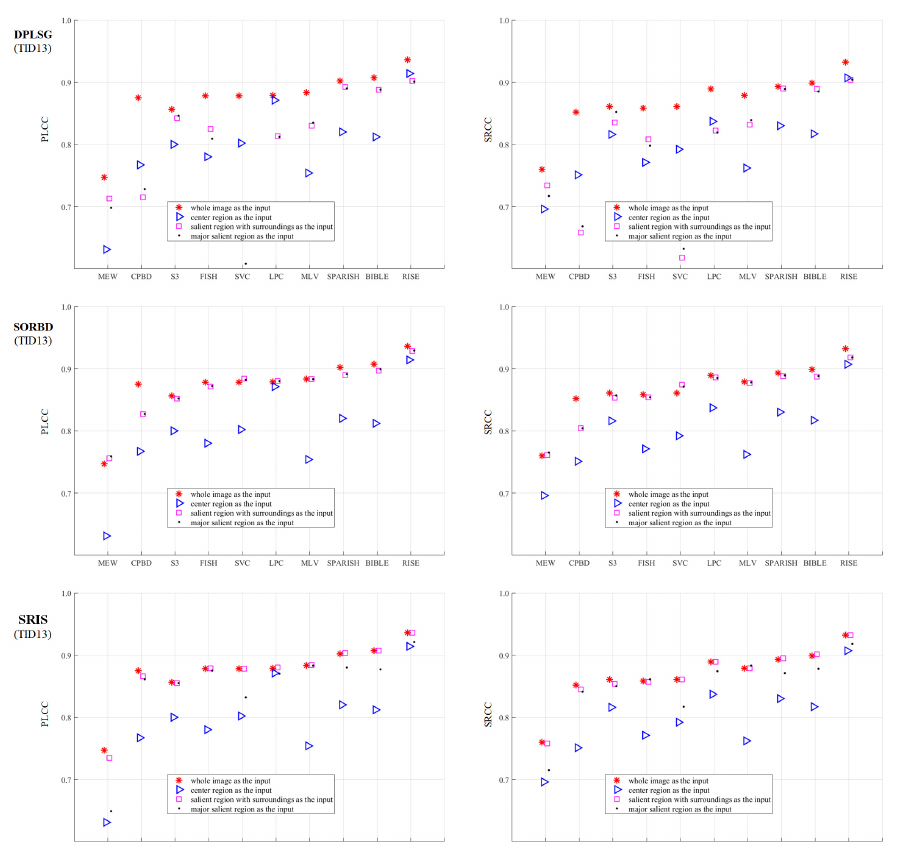
Figure 7. Comparison of BSIA performance on the TID13 Gaussian blurring images. The metric values using salient region inputs are slightly inferior to those obtained from the WI input ( ∗ ), while the values are much better than those obtained using the CR input ( (cid:52) ). (The figure can be enlarged for